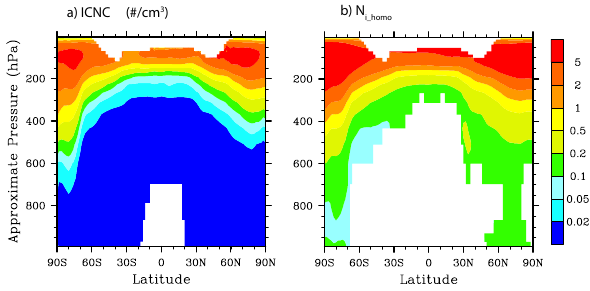
Figure 04 Fig. 4. Annual average zonal mean (a) in-cloud ice crystal number concentration (#/cm 3 ) predicted by the prognostic ice crystal equa- tion and (b) that calculated after the initial nucleation in the HOM